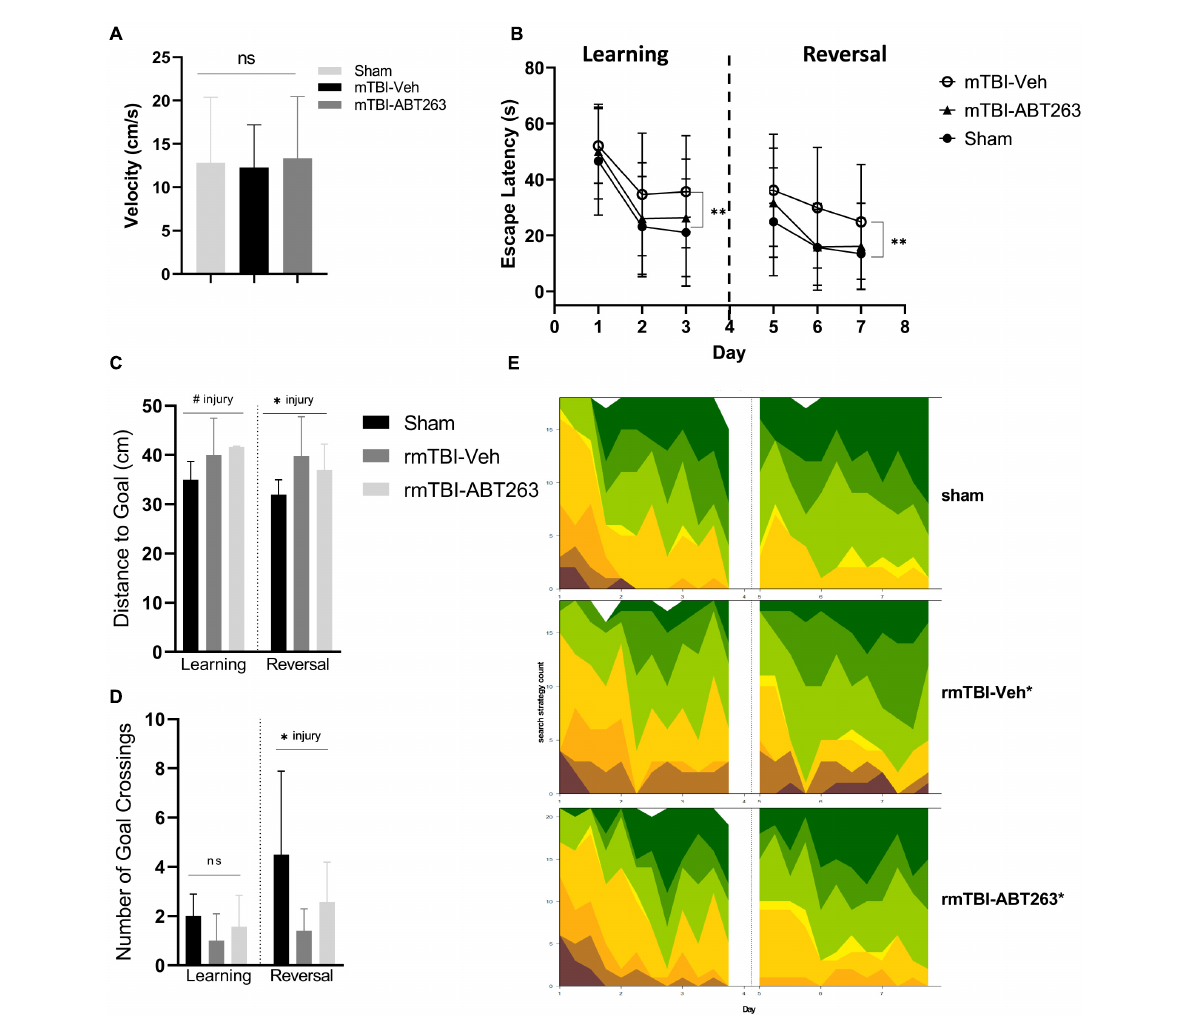
FIGURE8 Treatment with senolytic drug ABT263 improves cognitive dysfunction after rmTBI. Mice given rmTBI followed by vehicle or ABT263 treatment were tested in MWM compared to shams. Swim speed did not significantly differ between groups (A) . In the learning and reversal learning trials, rmTBI-veh mice had a significantly higher escape latency compared to both shams and rmTBI-ABT263 mice ( p < 0.001, main effect of injury treatment group) for both learning and reversal learning trials (B) . In the probe tests, treatment did not significantly affect the distance to the goal (C) nor number of goal crossings (D) . However, injury regardless of treatment significantly increased the distance to the goal (C) ( p < 0.05, main effect of injury) and number of goal crossings (D) ( p < 0.05, main effect of injury). Machine learning classifying of search strategies using RTrack (E) confirmled that sham and rmTBI-ABT263 mice used significantly more goal-oriented strategies compared to rmTBI-veh mice ( p < 0.0001, x 2 = 29.47, Chi square). Error bars represent standard deviation with an n of 8 per group. Statistical significance is marked